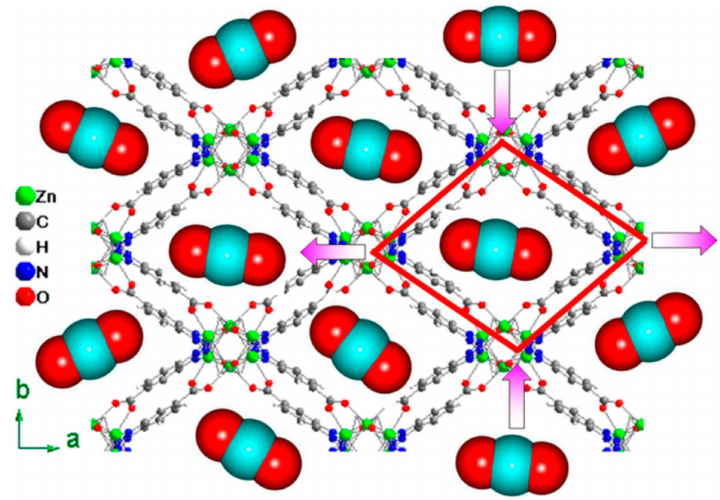
Figure 1. Selective adsorption of CO 2 by [Zn 3 (btca) 2 (OH) 2 ](guest) n . Reprinted with permission from Ref. [53]. Copyright 2015, American Chemical Society.